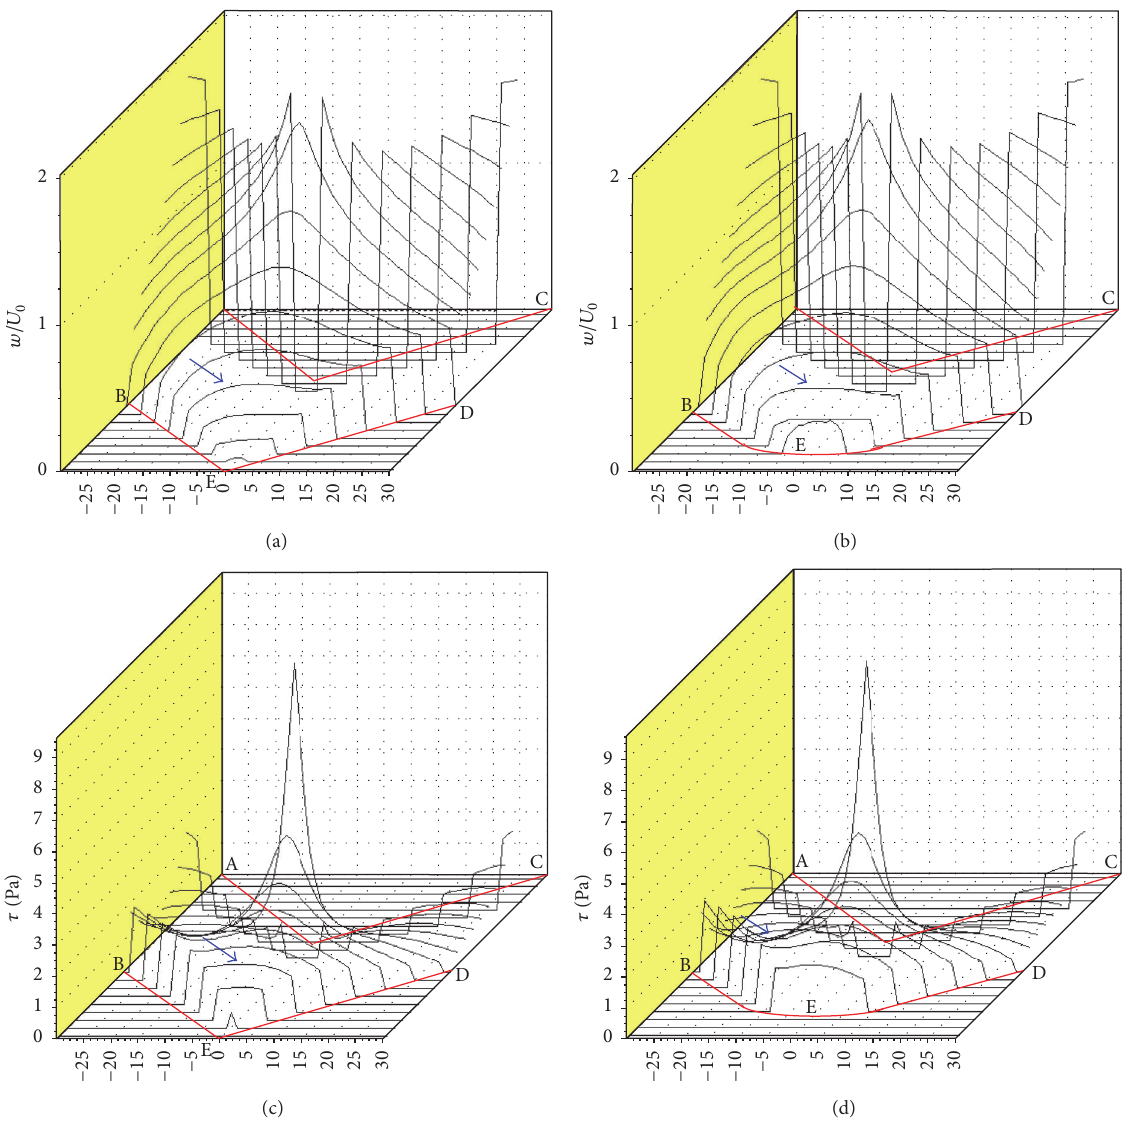
Figure 12: Computational 3D diagrams for dimensionless flow velocity 𝑤 (a, b) and for dimensional tangential stress 𝜏 (c, d) for the viscous flow of a plasticine workpiece model through obtuse-angled equal channel angular dies AOC–BED of Segal (a, c) and Iwahashi geometries (b, d) with channel intersection angles ∠ (AOC) = 2 𝜃 = 105 ∘ and external rounding BED in channel intersection zones 𝑅 = 15mm (b, d), where the inlet AB is at the left and the outlet CD is at the